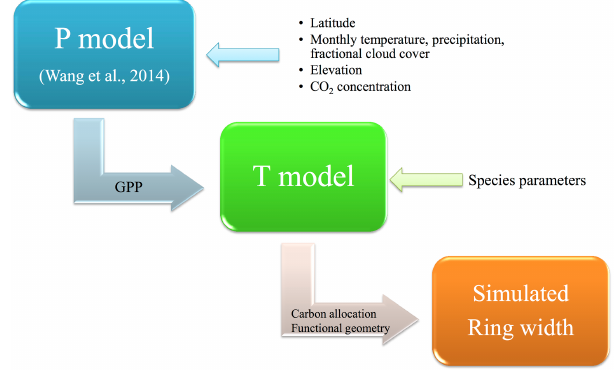
Figure 1. Model application flow. We combined the simple light- use efficiency and photosynthesis model ( P model) with a carbon allocation and functional geometric tree-growth model to simulate tree growth (e.g. ring width). The inputs to the P model are latitude, elevation, [CO 2 ], monthly temperature, precipitation, and fractional cloud cover. Potential gross primary productivity (GPP) simulated by the P model drives the T model. The T model also requires a limited number of species-specific parameter values to be